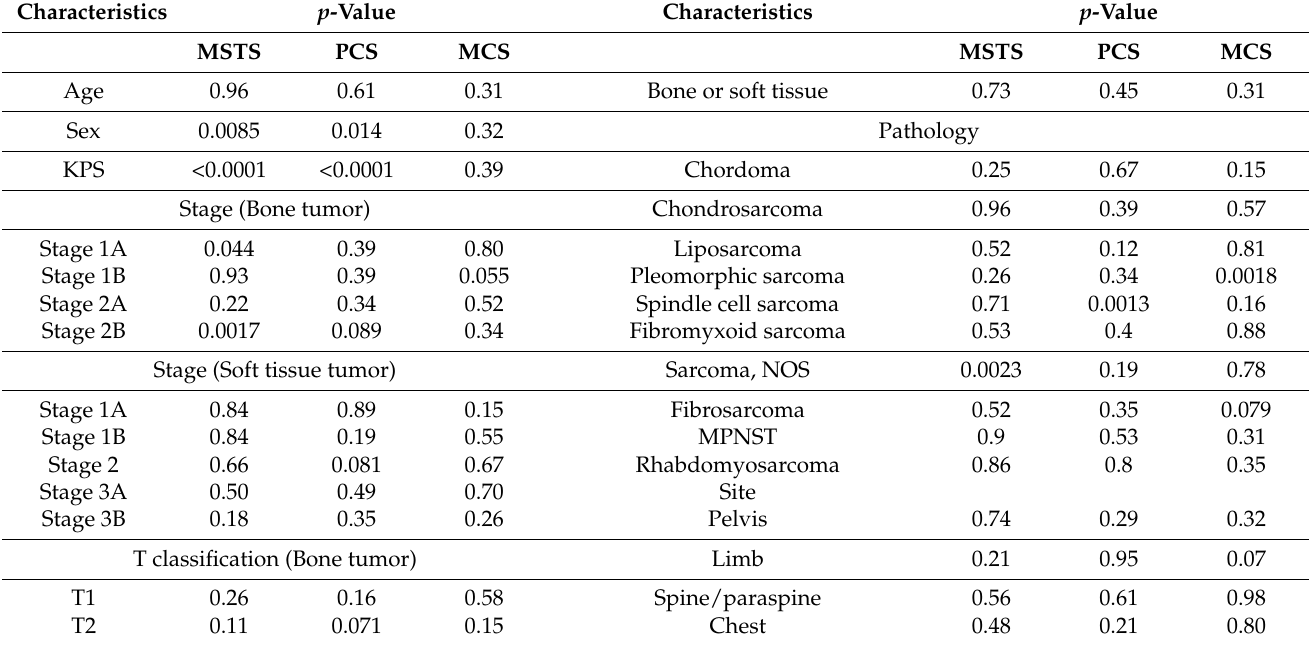
Table 2. Predictive factors for normalized scores at the final follow-up determined using univariate analyses. Characteristics p -Value Characteristics p -Value MSTS MSTS